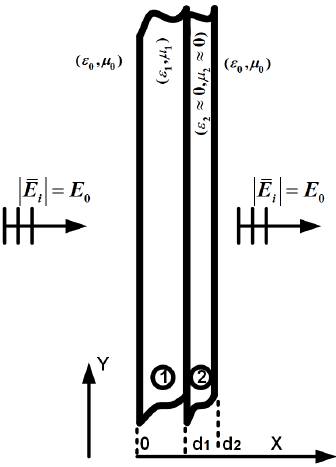
Figure 2. A DNZ slab coupled with a high dielectric slab. A plane wave with TE z polarization is incident on the structure perpendicularly.